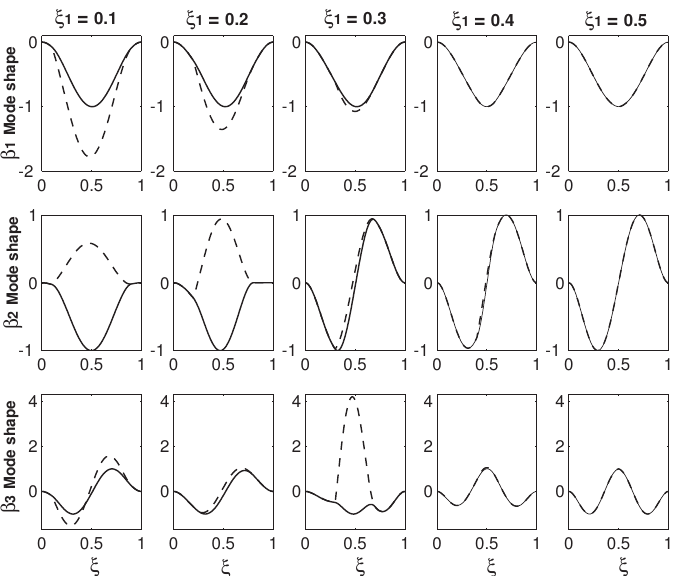
Figure 6. The mode shape variations of the first three eigenfrequencies ( β 1 , β 2 and β 3 ) as the functions of the overhang length ξ 1 . The first, second and third rows correspond to the mode shapes of β 1 , β 2 and β 3 , respectively.